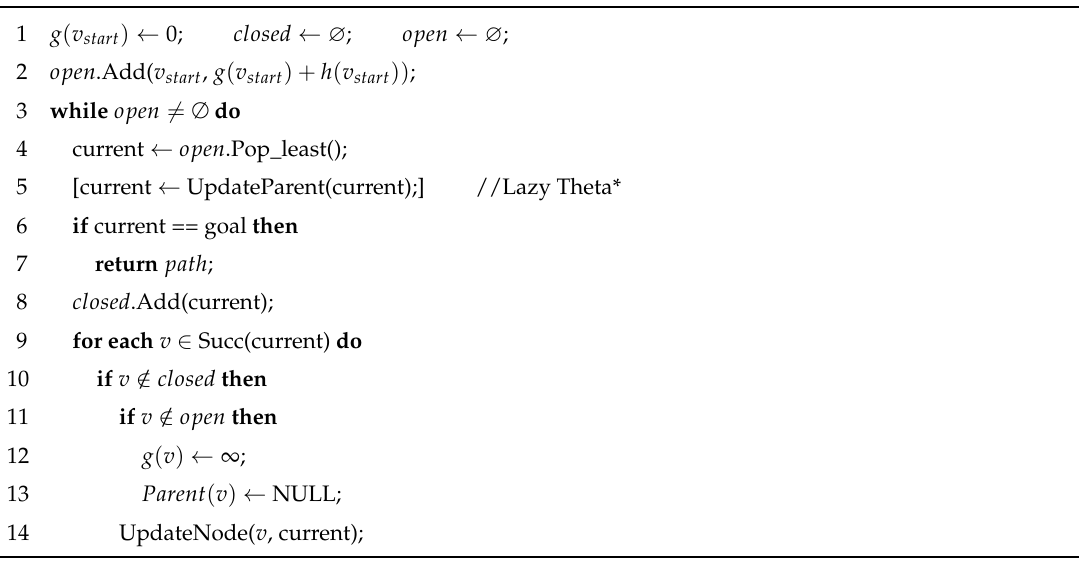
Algorithm 1 : Theta* and Lazy Theta*